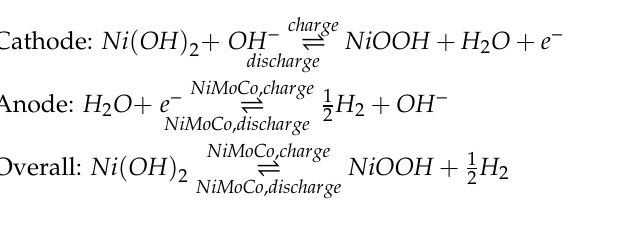
Figure 46. Internal construction of the hermetically sealed (i.e., airtight) Ni-H 2 battery [143].